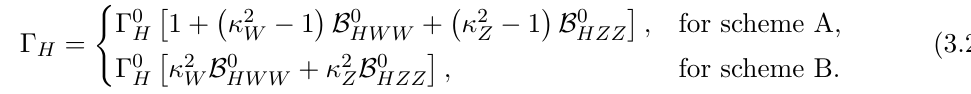
b (cid:22) b decay channel. The SM value of the combined similar to that in the H !